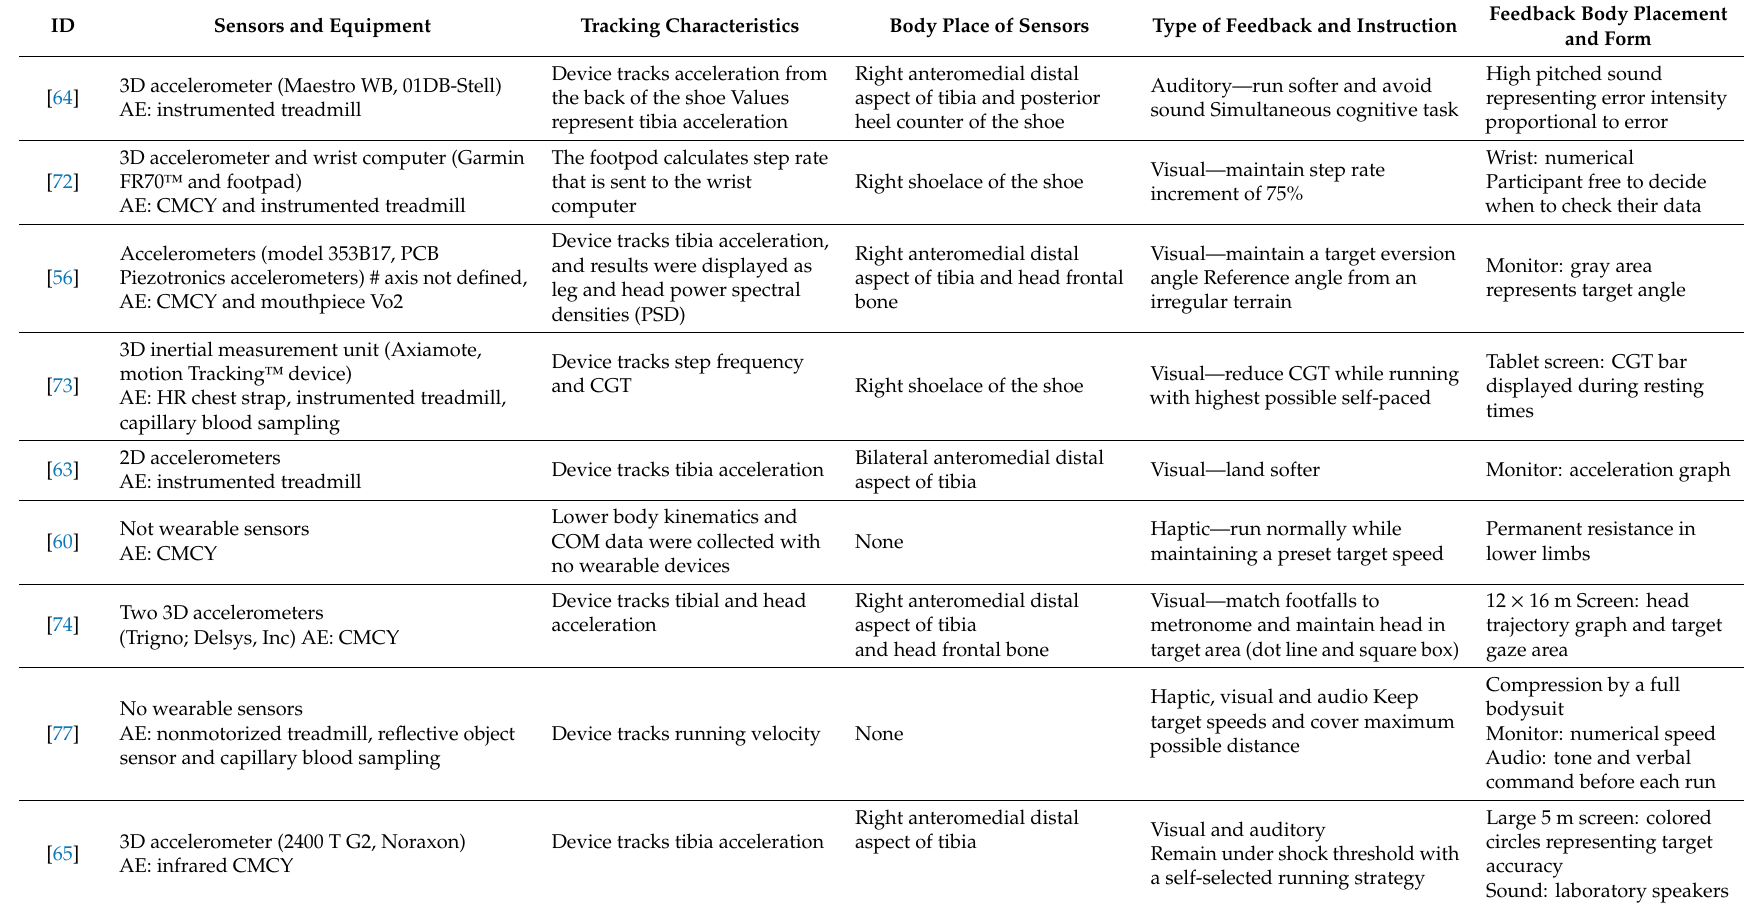
Large 5 m screen: colored circles representing target accuracy Sound: laboratory